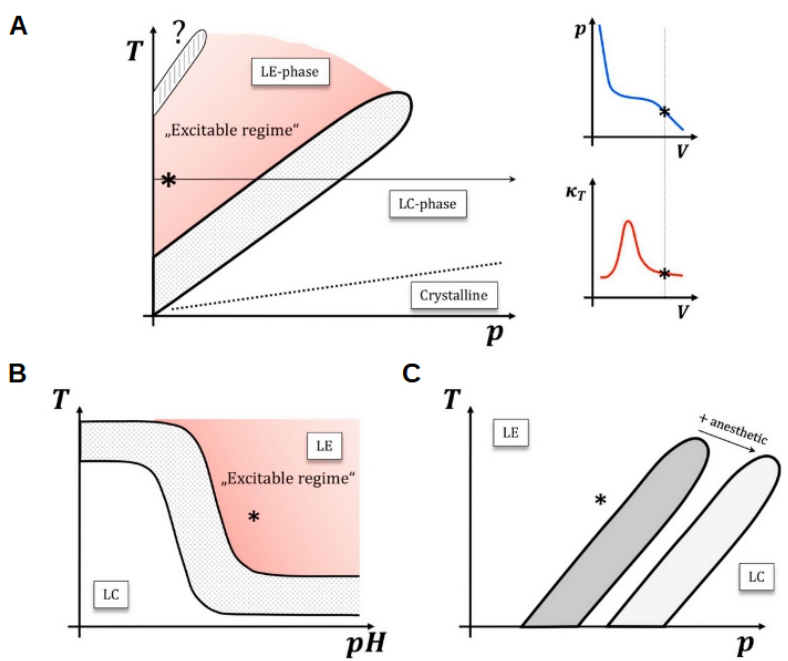
Figure 4. Scheme showing the relation between membrane phase state and excitability. ( A ) The cell membrane is excitable if the resting state (asterisk) is in the vicinity of an ordered-disordered transition (e.g., from liquid expanded (LE) to liquid condensed phase (LC) in liquid monolayers; or from lamellar fluid to gel in lipid bilayers). This is illustrated by the P-V isotherm and the derived isothermal compressibility on the right (the arrow illustrates the respective slice through the phase plane). State changes move the system state (asterisk) through phase space and hence change the physical properties of the membrane. At low T / high P the membrane “freezes” into a crystalline-like state. ( B ) In a T-pH plot, the phase boundary is sigmoidal. The underlying reason for this additional nonlinearity is that the headgroups of membrane molecules are ionizable. This results in a nonlinear change of the transition temperature with pH. Thus, acidification at constant T and P can move the resting state into the LC phase. ( C ) According to the melting point depression theory [162,166], anesthetics leave the resting state in the disordered phase, but increase its distance to the transition. This figure is reproduced from ref. [164] with permission from